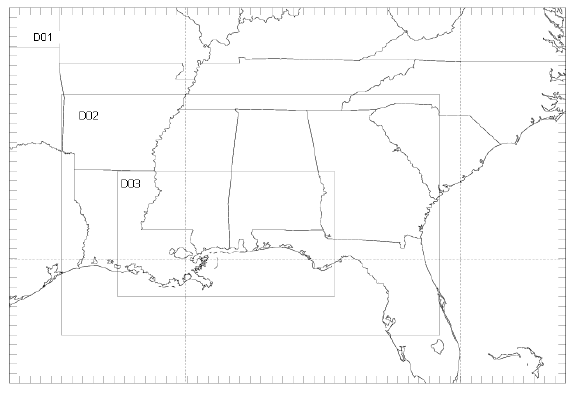
Figure 2 : Modeling domains used in WRF Table 1 : Details of the physics and grid